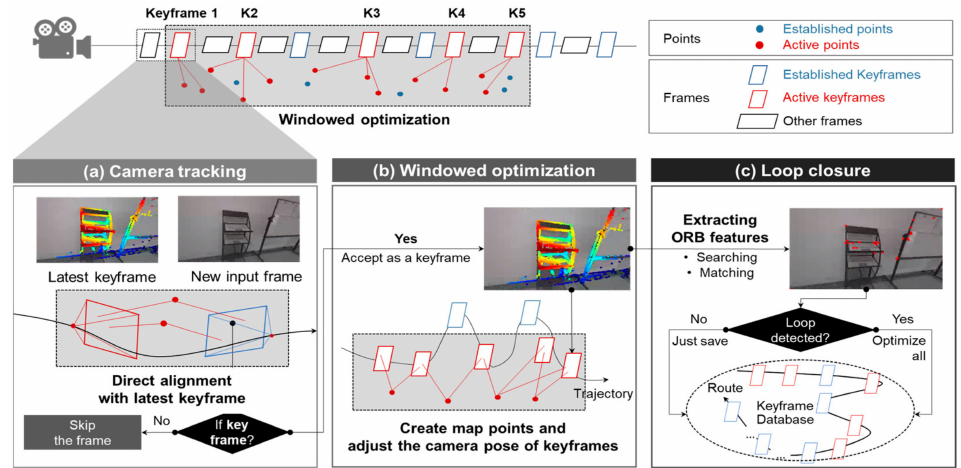
Figure 1. Framework of the original LDSO. Note: sliding window = a window to maintain five to seven key frames and 2000 matching points; active keyframes = 5 active keyframes in sliding window; marginalized keyframes = keyframes out of sliding window; active points = points of active keyframes in sliding window; marginalized points = points out of sliding